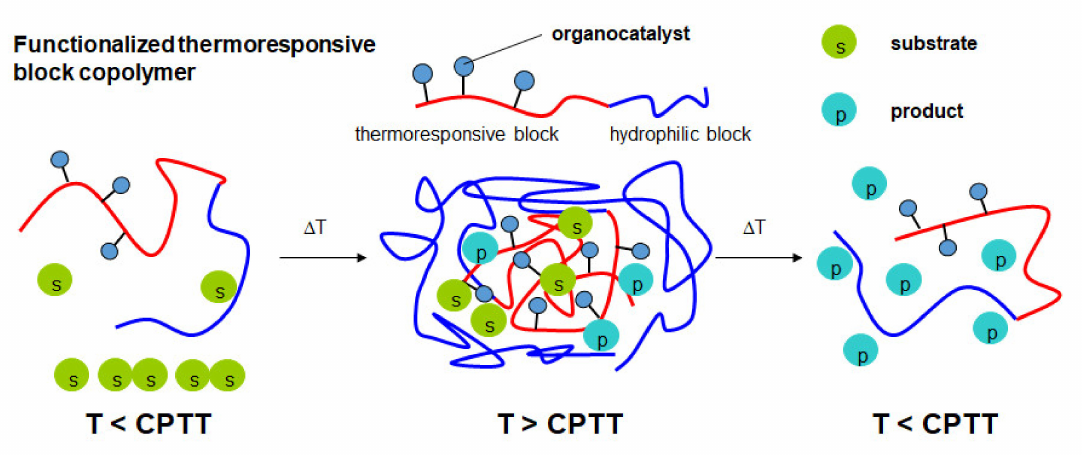
Figure 2. Basic principle of micellar organocatalysis using functionalized thermoresponsive block copolymers (CPTT = critical volume phase transition